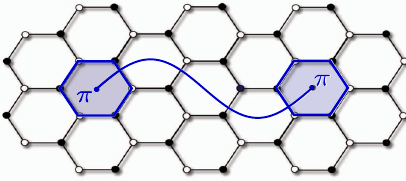
FIG. 1. For a lattice with periodic boundaries, (cid:1) fluxes can be inserted in pairs. Each flux threads a hexagon (highlighted in blue) of the honeycomb lattice, and the pair is connected by a branch cut (blue line). Hopping processes crossing the branch cut acquire a phase e i (cid:1) ¼ (cid:2) 1 .